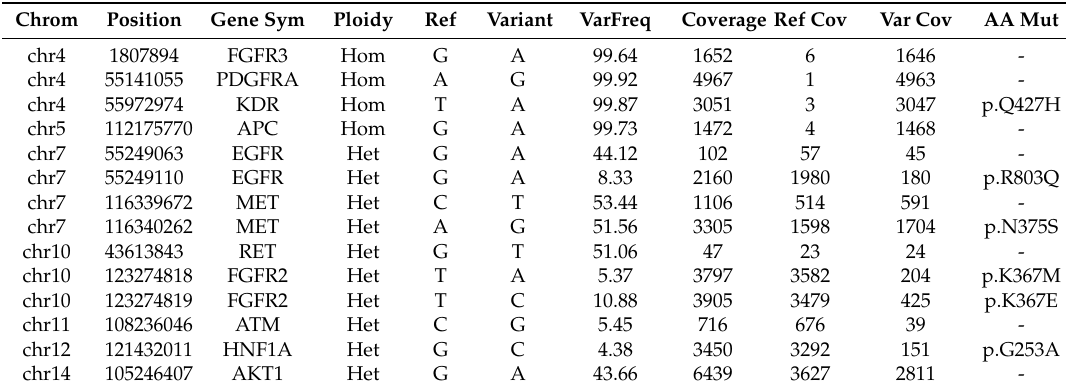
Table 2. Target variants of high-risk cSCC no. 1 specimen.